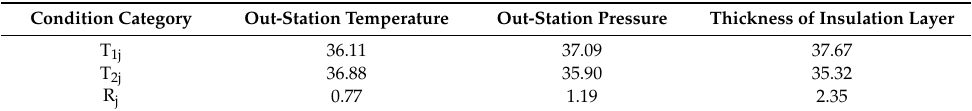
Table 4. Range analysis of total exergy